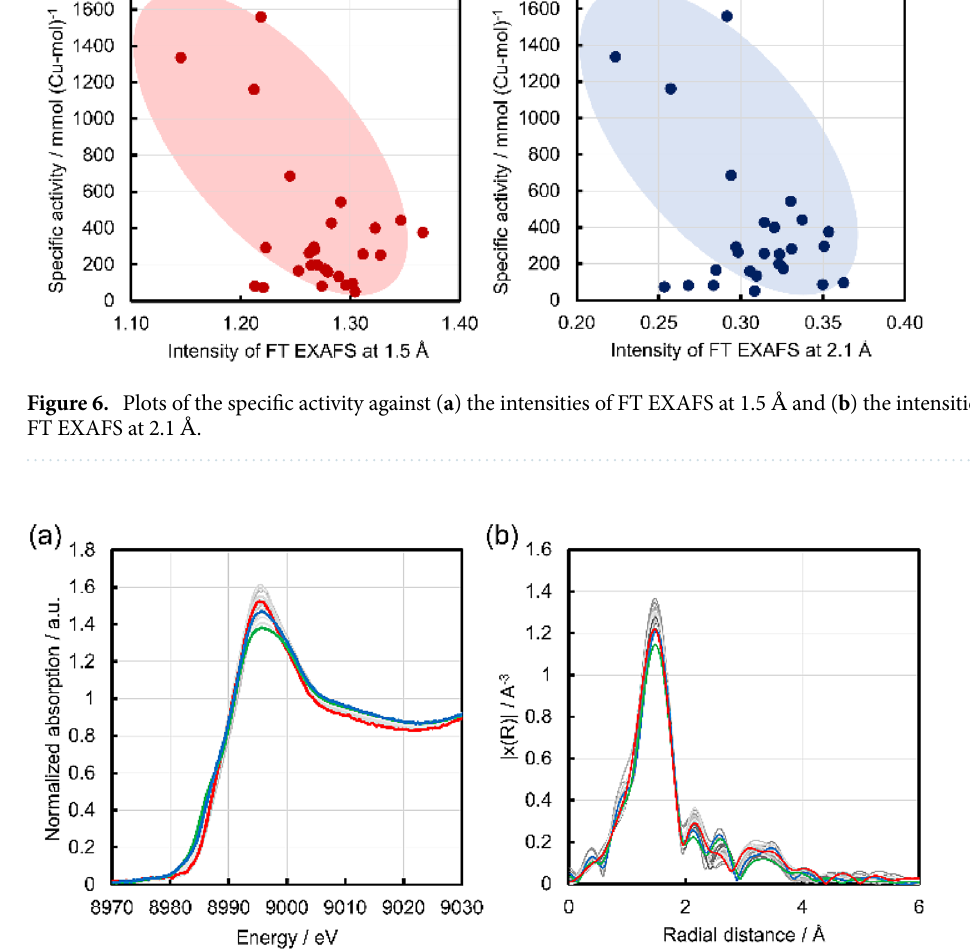
Figure 7. Cu K-edge XANES and FT-EXAFS spectra for Cu(0.64)FAU(14.9) (green), Cu(0.64)FAU(110) (blue), Cu(0.40)MOR(220) (red), and the other Cu zeolites